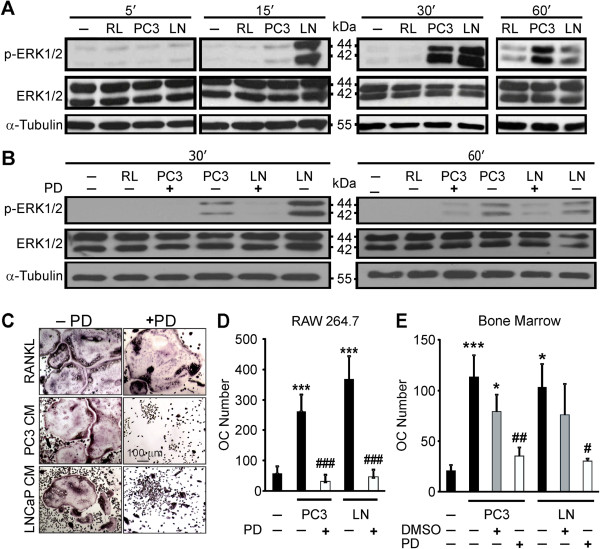
Prostate cancer-derived factors induce activation of MEK/ERK pathway in osteoclast precursors. A) RANKL-primed RAW 264.7 cells were cultured for 5–60 min untreated (negative control), treated with RANKL, or exposed to 10% PC3 or LNCaP CM. Total protein was extracted and the levels of phosphorylated ERK1/2 (p-ERK1/2), total ERK1/2, and α-tubulin were assessed by immunoblotting. B) RANKL-primed RAW 264.7 cells were pretreated for 1 h with 0.1% DMSO vehicle, or 100 μM MEK inhibitor (PD98059), washed and cultured for 30–60 min untreated, treated with RANKL, or 10% PC3 or LNCaP CM. Total protein was extracted and immunoblotted for p-ERK1/2, total ERK1/2 and α-tubulin. C-E) RANKL-primed RAW 264.7 (C-D), or bone marrow (E) cells were pretreated for 1 h with 0.1%, DMSO vehicle (gray bars), or MEK inhibitor, 100 μM for RAW 264.7 and 50 μM for bone marrow cells (white bar), washed and cultured for 2 days (negative control), treated with RANKL, or 10% PC3 or LNCaP (right column), and the average osteoclast numbers were assessed. C) Representative images of osteoclasts formed from RAW 264.7 cells in different conditions. D-E) Average number of osteoclasts formed in RAW 264.7 (D) or bone marrow (E) cultures at different conditions. Data are means ± SEM; n = 4-10 experiments for RAW 264.7 cells, n = 3-7 experiments for bone marrow cells; *P < 0.05, ***P < 0.001 indicate significance compared to negative control; #P < 0.05, ##P < 0.01, ###P < 0.001 compared to no inhibitor, assessed by Student’s t-test.